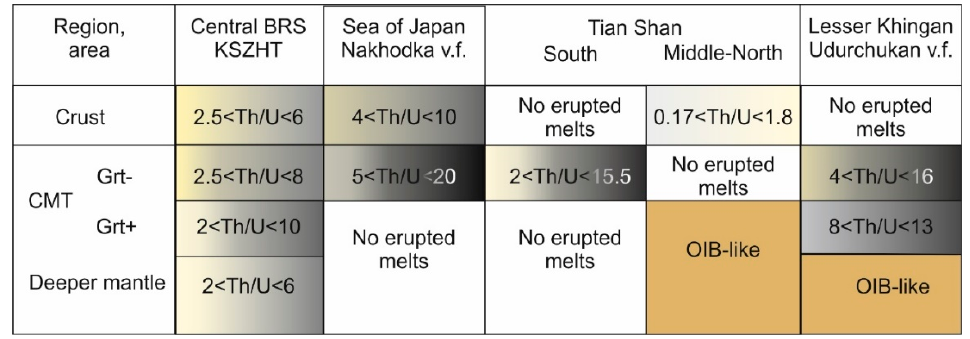
Figure 16. Ranges of Th/U ratios in the KSZHT volcanic rocks in comparison with those from CMT deep-seated sources in other Asian regions. Data are from [9,112] and this work.